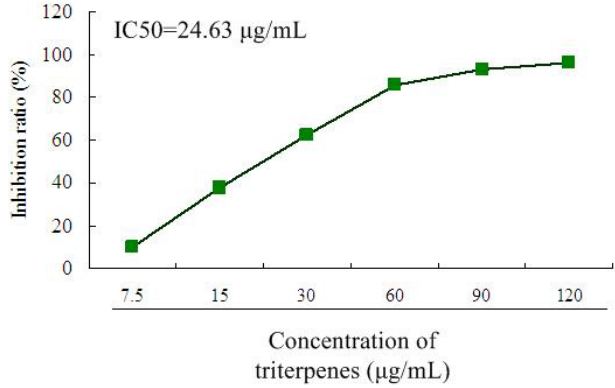
Figure 4. Proliferation inhibition effect of triterpenes on A549 cells after treatment for 36